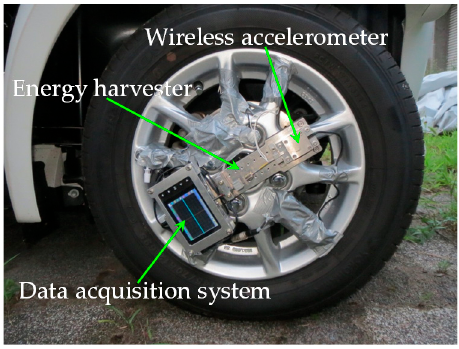
Figure 17. Apparatus for the actual-vehicle experiment.